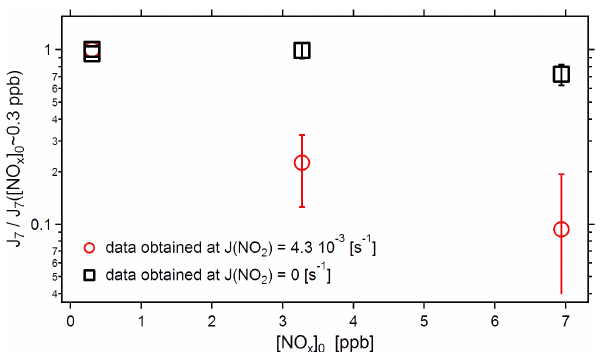
Fig. 8. J 7 normalized to J 7 measured at [NO x ] 0 ∼ 0ppb as a function of [NO x ] 0 . Red circles: data points measured at J (NO 2 ) = 4.3 × 10 − 3 s − 1 , black squares: data measured at J (NO 2 ) ∼ 0s − 1 . In the presence of UVA light, suppression of J 7 by NO x addition was more pronounced than in the absence of UVA light. As J 7 for [NO x ] ∼ 0.3ppb (reference points) was forced to be 1, no error limits are given for both reference points. Other er- rors are determined from error propagation setting the error for the reference points to zero. Note the logarithmic scale for J 7